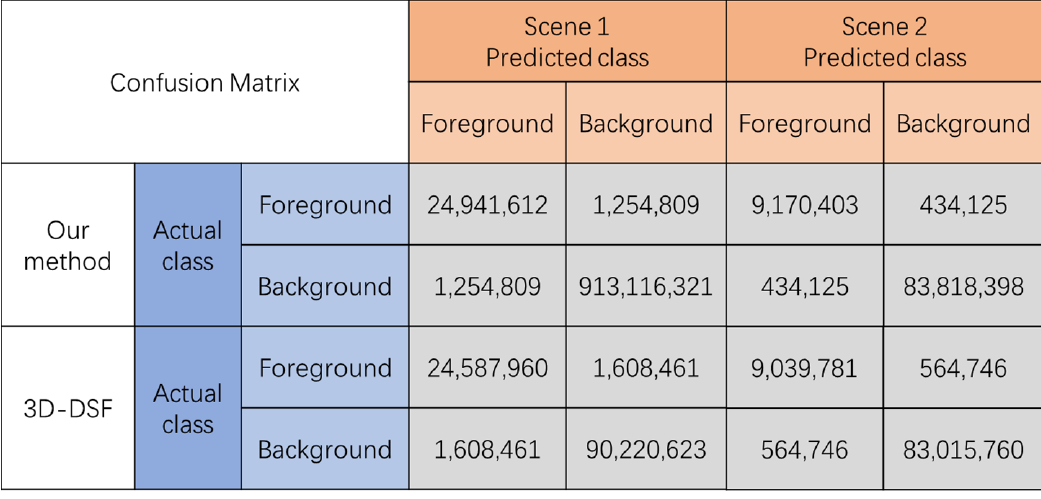
Figure 15. CM on two scenes using our method and 3D ‐ DSF.